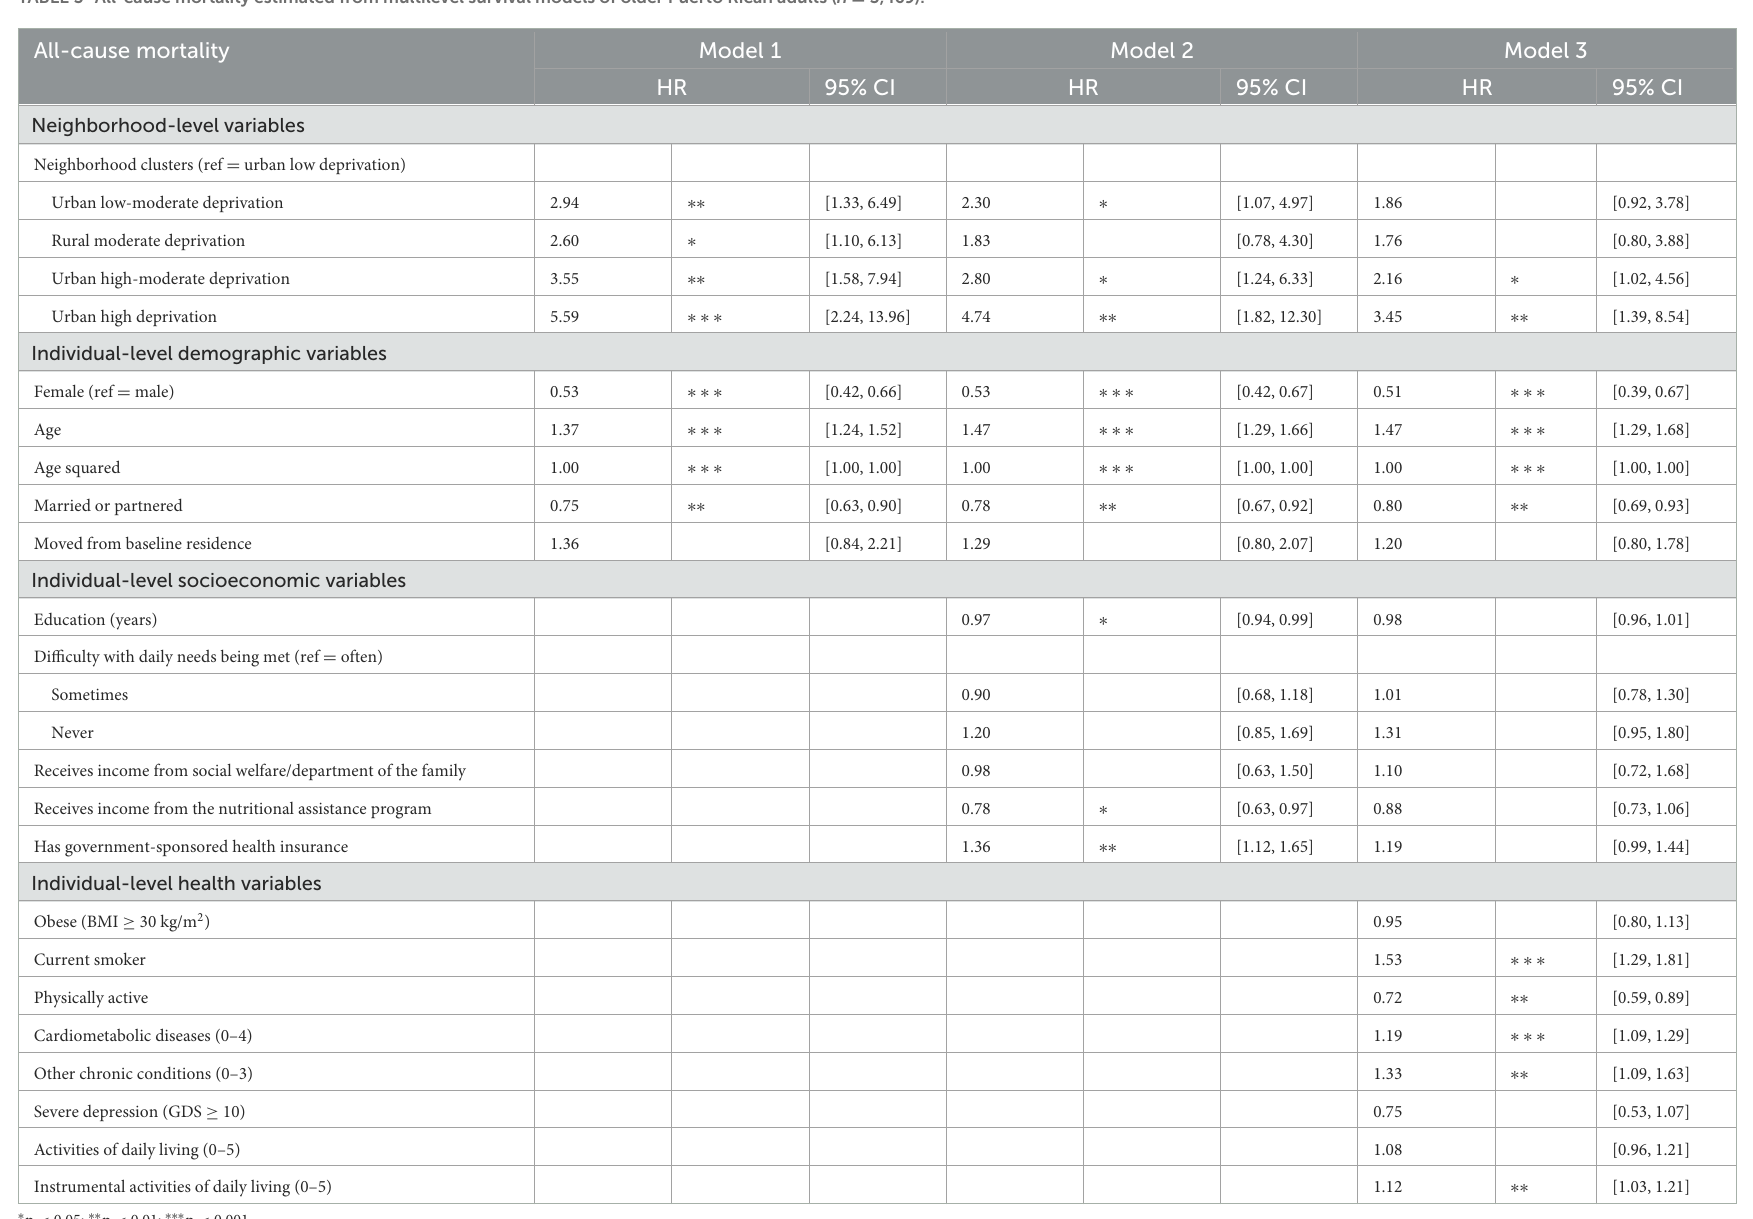
TABLE 3 All-cause mortality estimated from multilevel survival models of older Puerto Rican adults ( n = 3,469). All-cause